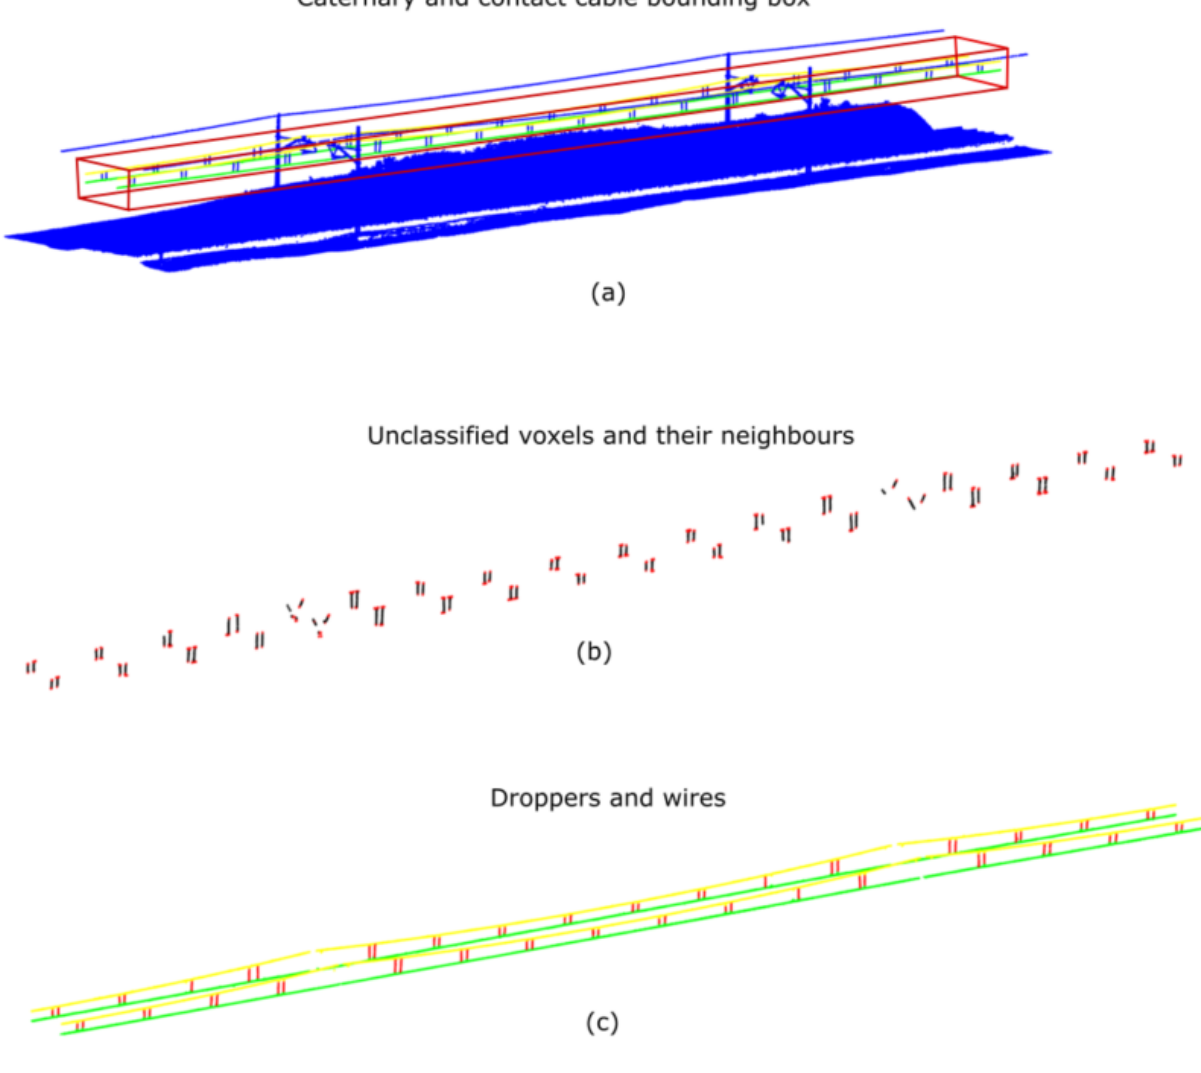
Figure 9. Droppers’ segmentation workflow: ( a ) bounding box of contact–catenary wires; ( b ) voxels inside the bounding box unclassified coloured in black and their neighbours in red; ( c ) droppers coloured in red, catenary wires in yellow, and contact wires in green.